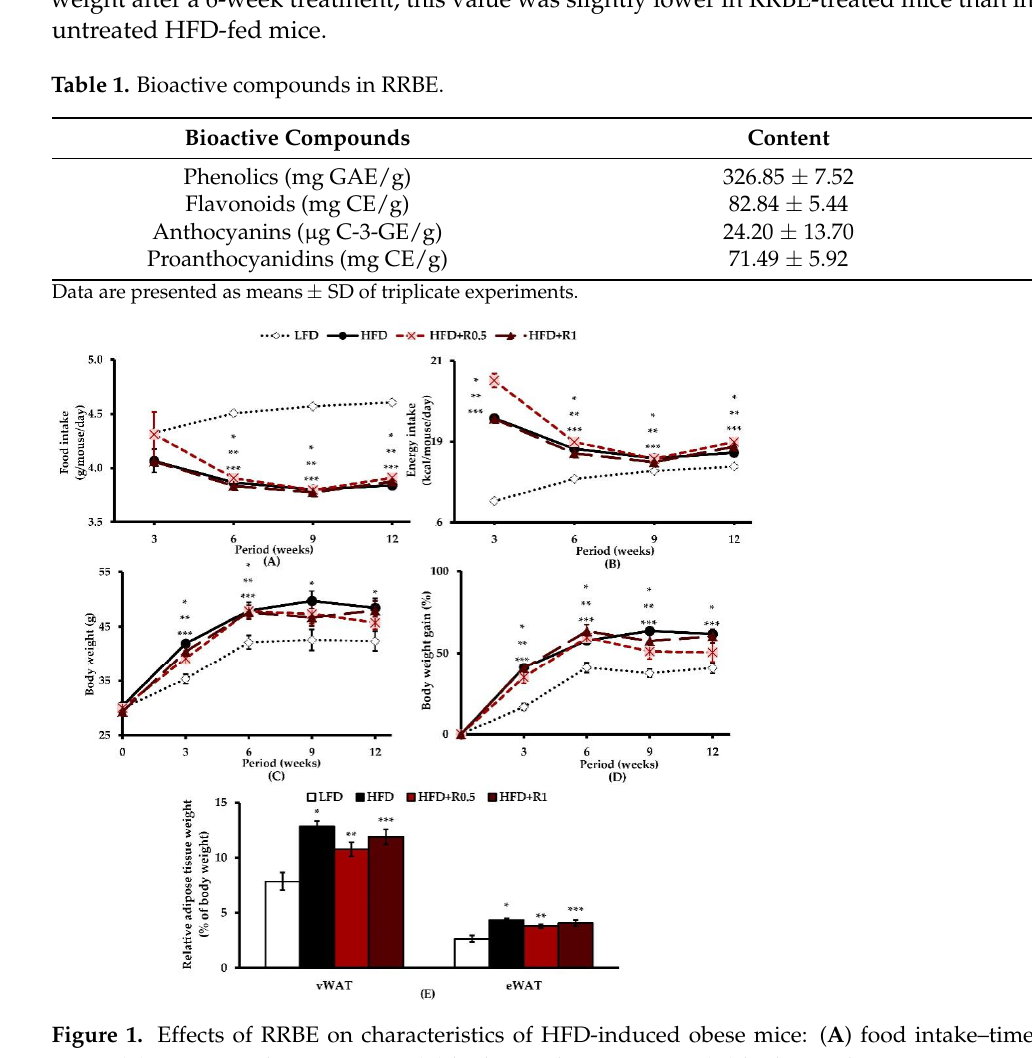
Table 1. Bioactive compounds in RRBE.